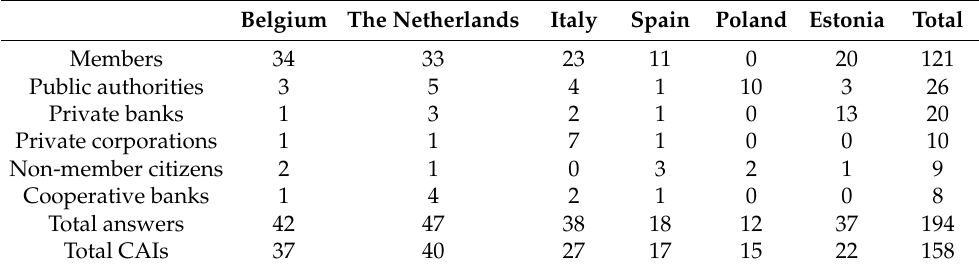
Table 6. Today main investors in CAIs.